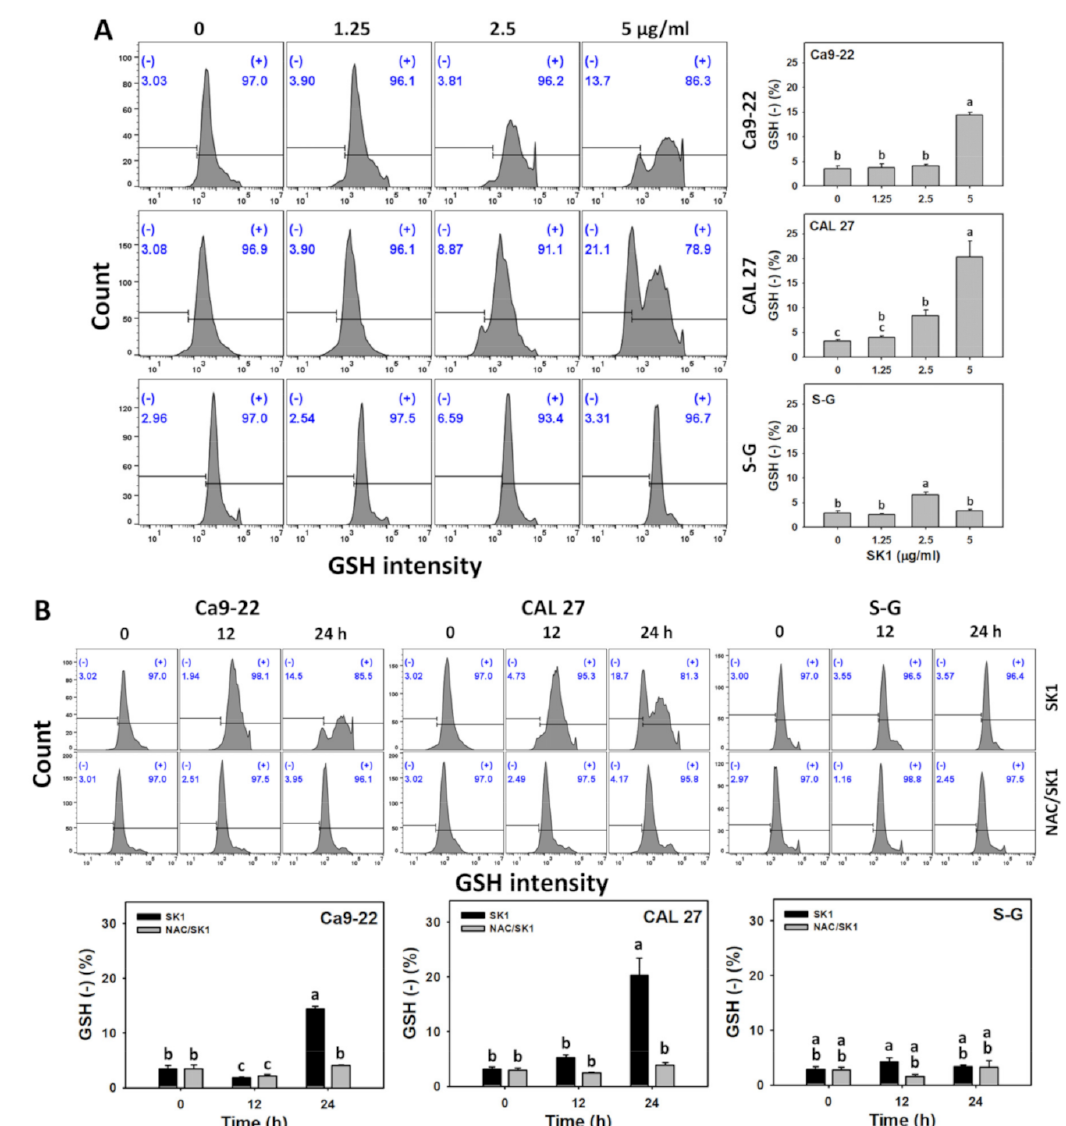
Figure 8. Antioxidant responses (GSH) of SK1. ( A ) GSH assays of SK1. Non-malignant (S–G) and oral cancer (Ca9-22 and CAL 27) cells were treated with SK1 (0 (0.1% DMSO in medium), 1.25, 2.5, and 5 µ g/mL) for 24 h. ( B ) GSH assays of NAC/SK1. NAC/SK1 indicated that cells were pretreated with NAC and posttreated with SK1 5 µ g/mL for 0, 12, and 24 h. ( − ) inserted at the histogram is counted for the percentage of GSH ( − )(%). Data, mean ± SD ( n = 3). Statistical software provided non-overlapping low-case letters indicate significant results for multi-comparison ( p <